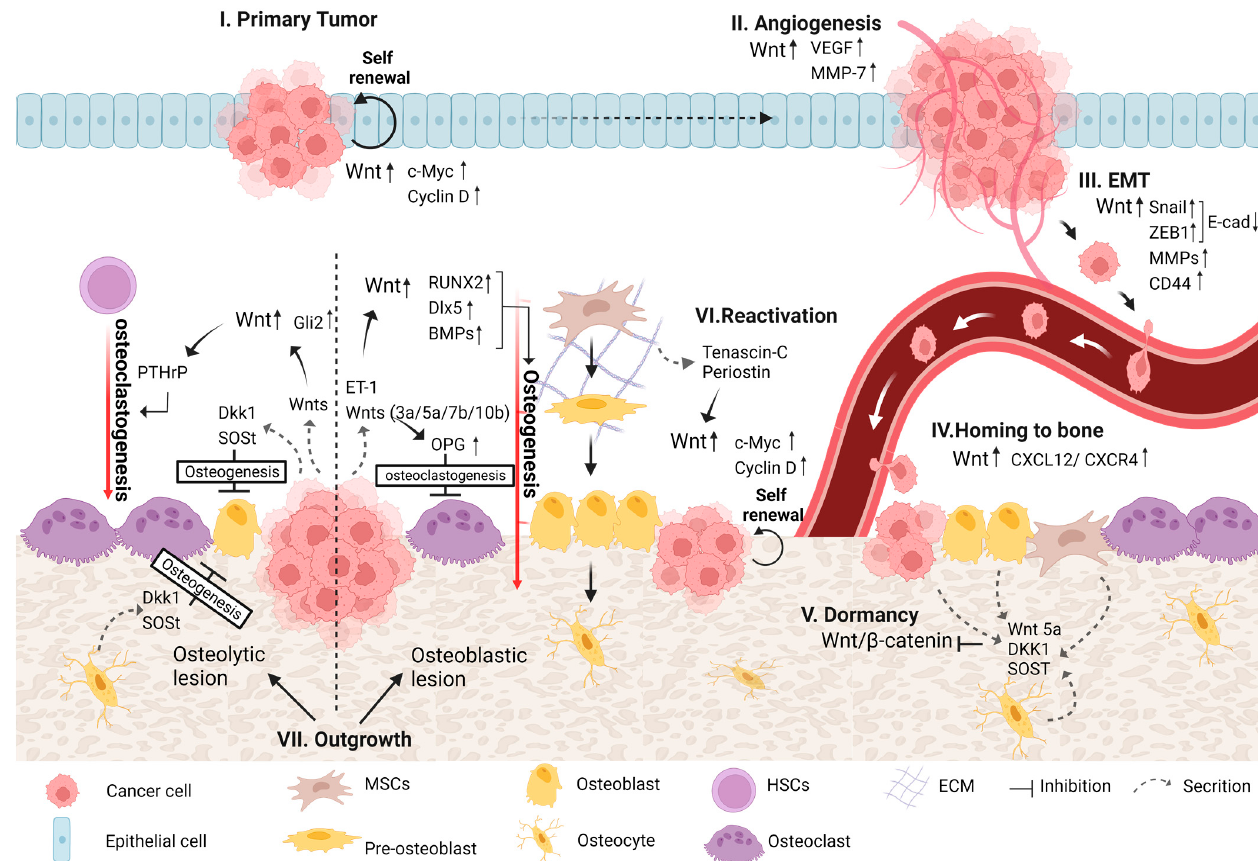
Figure 2. Wnt signaling in the development of bone metastases. The roles of Wnt signaling pathways in multiple steps during the process of bone metastasis formation and progression. The primary tumor progresses (I, II). EMT is taking place, and invading cells depart from the primary tumor (likely breast, prostate, lung, multiple myeloma, etc.) and intravasate the vasculature (III). Under the effects of Wnt and other attractants, the cells home and attach to bone marrow niches (IV). Interactions within the bone marrow compartments may drive long-term dormancy (V). Following a myriad of cues, quiescent cells are reactivated (VI), and osteoblastic or osteoclastic outgrowth may cause bone deformation and lesions. The Wnt-related landscape of these processes is portrayed in detail in the text below.